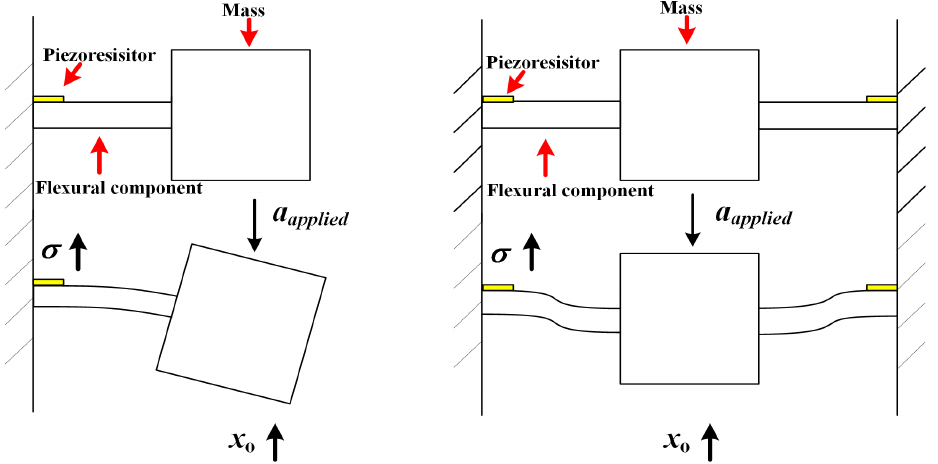
Figure 1. The dependency between x o and σ in the conventional piezoresistive accelerometer.